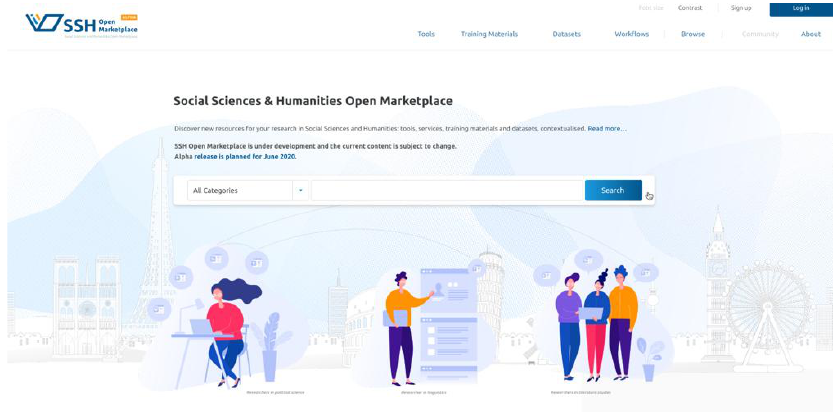
Figure 3 : Marketplace